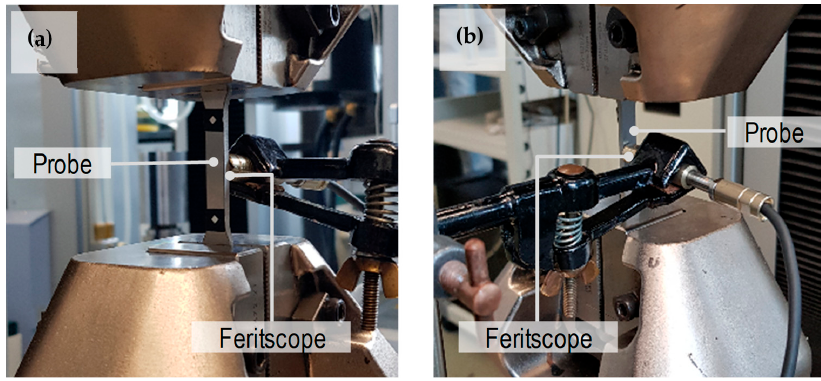
Figure 6. ( a ) Tensile test with a probe for in-site ferromagnetic content measurements ( b ) stress-strain response and evolution of martensite content as a function of plastic strain.